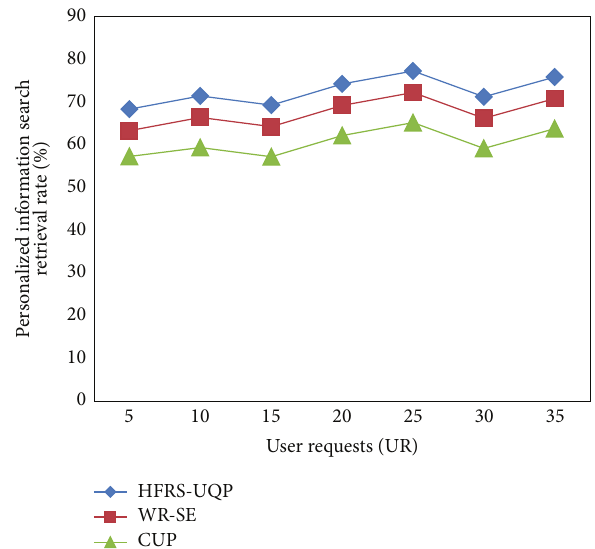
Figure 4: Performance of personalized information search retrieval